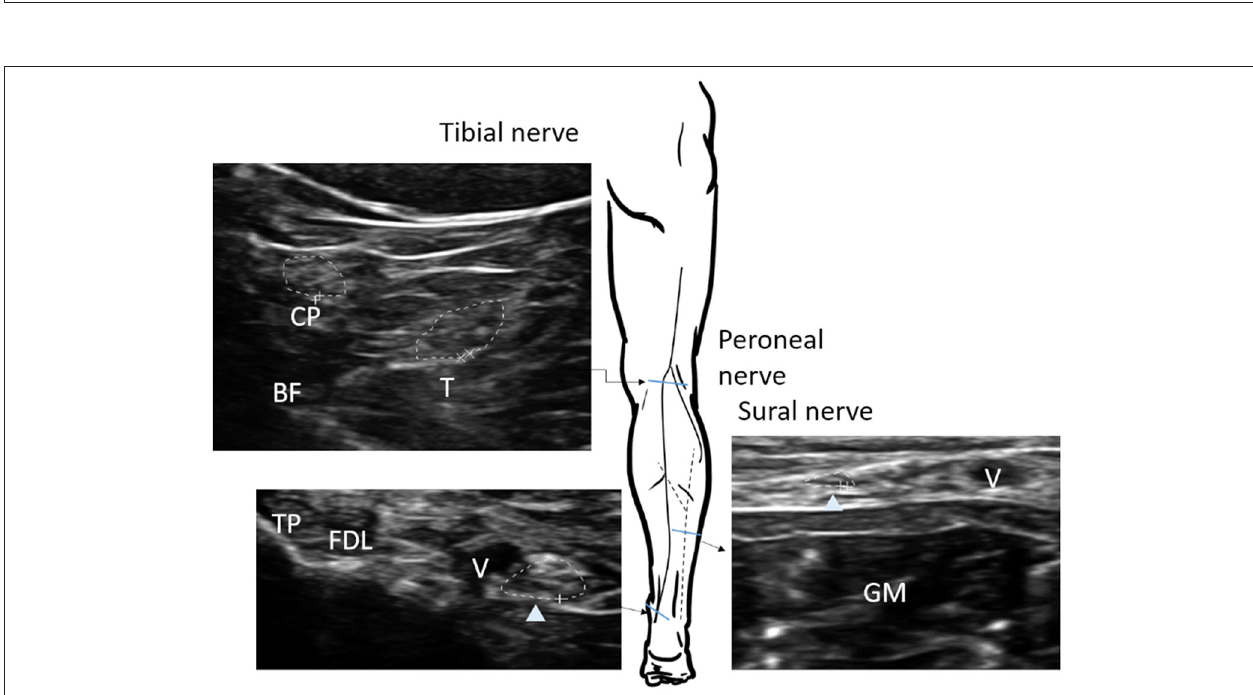
FIGURE 2 | Sites of nerve ultrasonography to determine the cross-sectional area (CSA) in the tibial, peroneal, and sural nerves. The CSA of each nerve (arrow head) is measured within the hyperechoic rim (dotted line). The tibial and peroneal nerves in popliteal fossa are defined as the location of the split by the sciatic nerve; sural nerve, 10cm proximal to the lateral malleolus of the calf next to the small saphenous vein. BF, biceps femoris muscle; T, tibial nerve; CP, common peroneal nerve; GM, gastrocnemius; TP, tibialis posterior; FDL, flexor digitorum longus; V, vein.